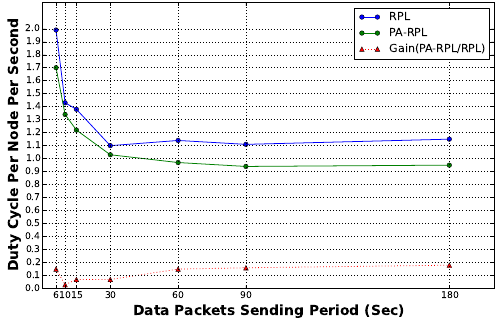
Figure 14. Gain as a function of sending